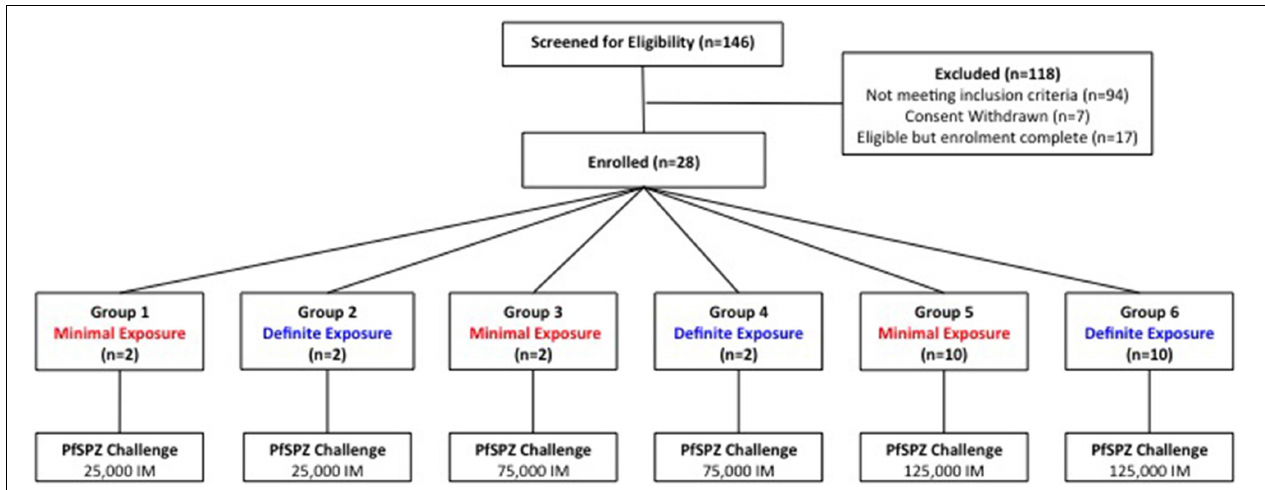
FIGURE 1 | Study design and volunteer recruitment. 118 participants were excluded following screening (refer to Figure S1 for details). In each group, the total dose of sporozoites was split between two injection sites and administered as two 50 μ L injections, one in each